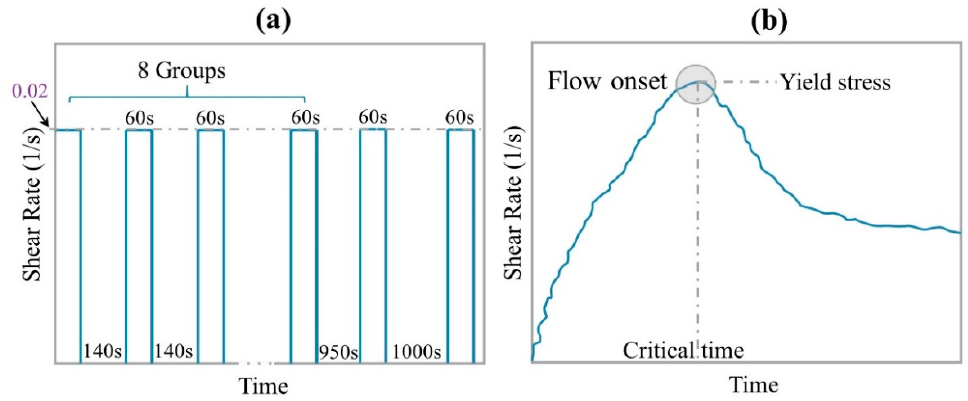
Figure 3. ( a ) Test procedure of static yield stress, and ( b ) static yield stress obtained from the peak value.